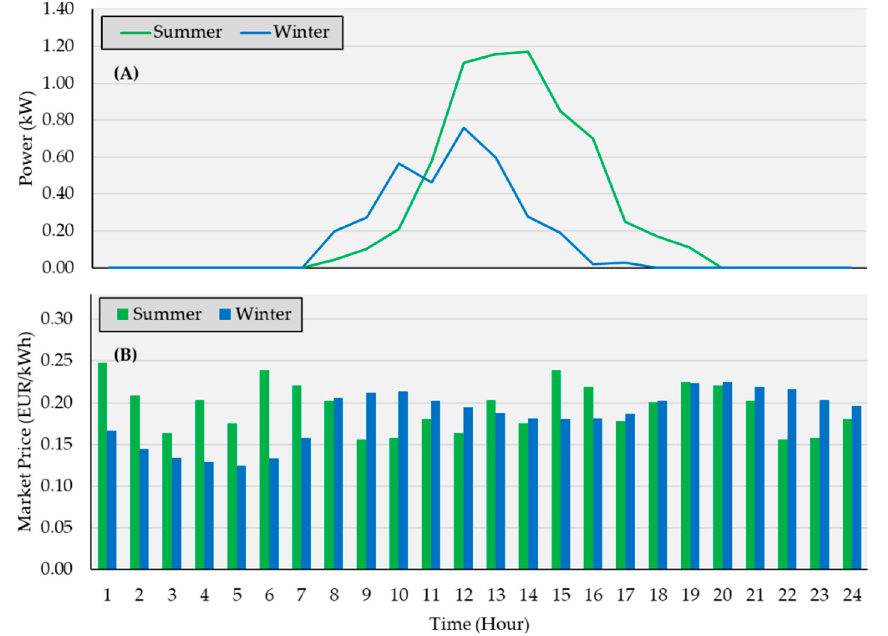
Figure 4. Input data for the case study: ( A ) photovoltaic (PV) production and ( B ) electricity market prices.